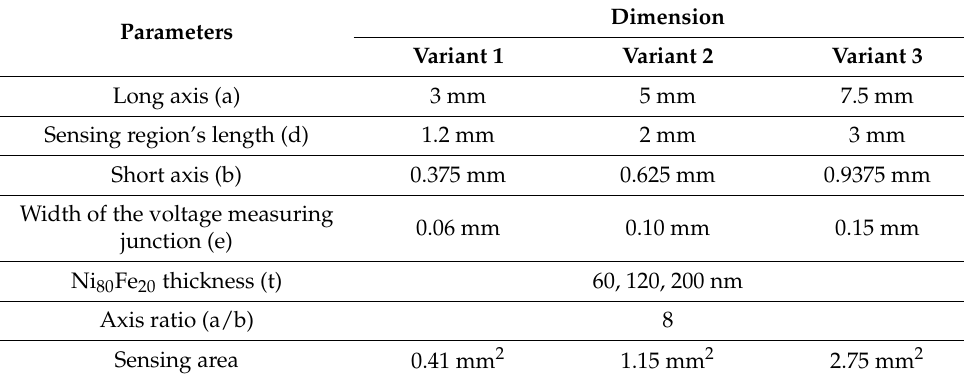
Table 1. Dimensions of the sensor variants based on the sensing area.